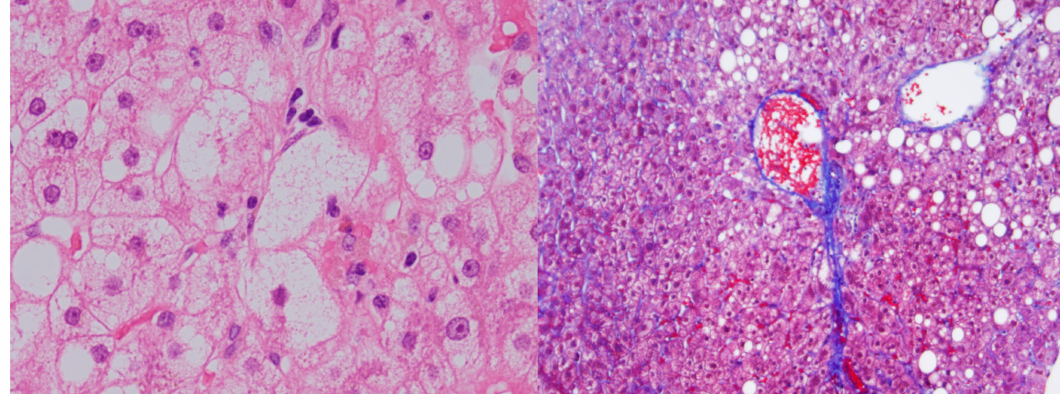
Figure 4. Liver biopsy findings of Hematoxylin and eosin ( left ) and Masson trichrome staining ( right ) in this study. (original magnifications: ( left ) × 400, ( right ) ×